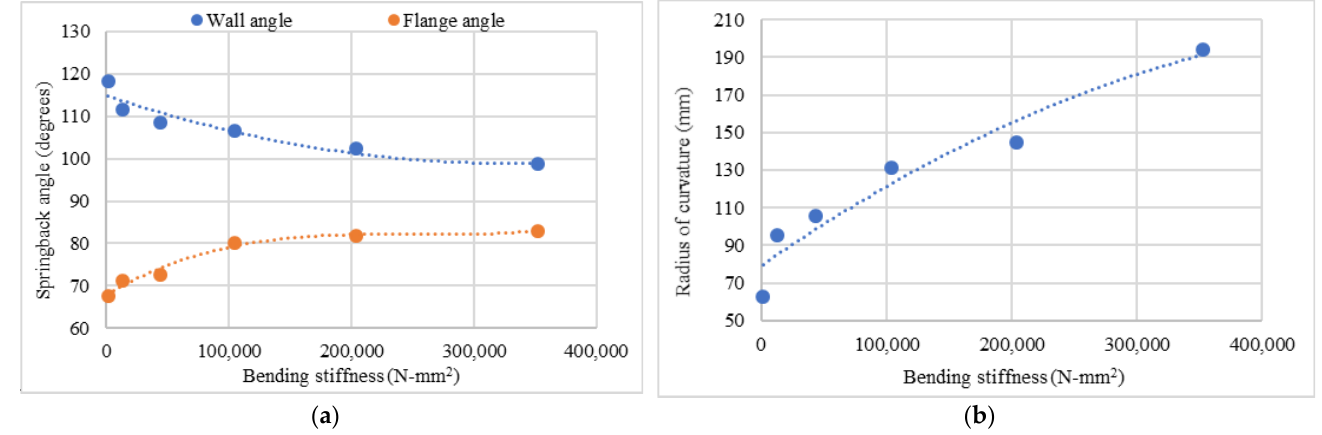
Figure 5. ( a ) Wall angle and flange angle vs. bending stiffness of single SA5182 sheets and ( b ) Variation of radius of curvature of the wall of SA5182 sheets with bending stiffness.